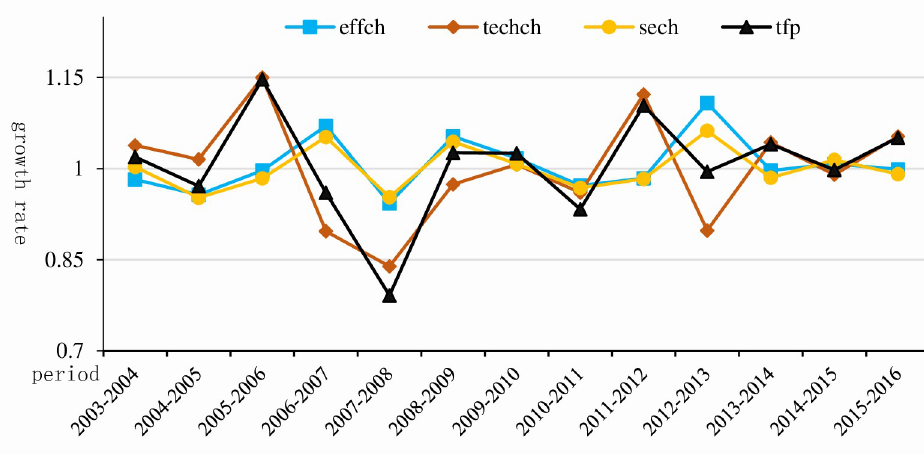
Fig 7. Trend of total factor productivity of marine fishery in China from 2003 to